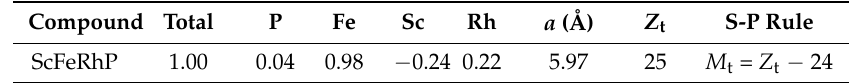
Table 3. Partial and total magnetic moments ( μ B ), calculated equilibrium lattice constant, Z t , and Slater-Pauling (S-P) rule for the ScFeRhP compound.